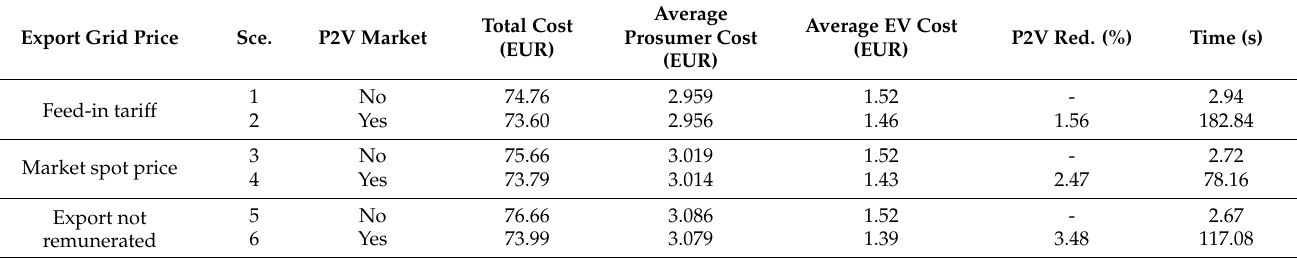
Table 3. Optimization